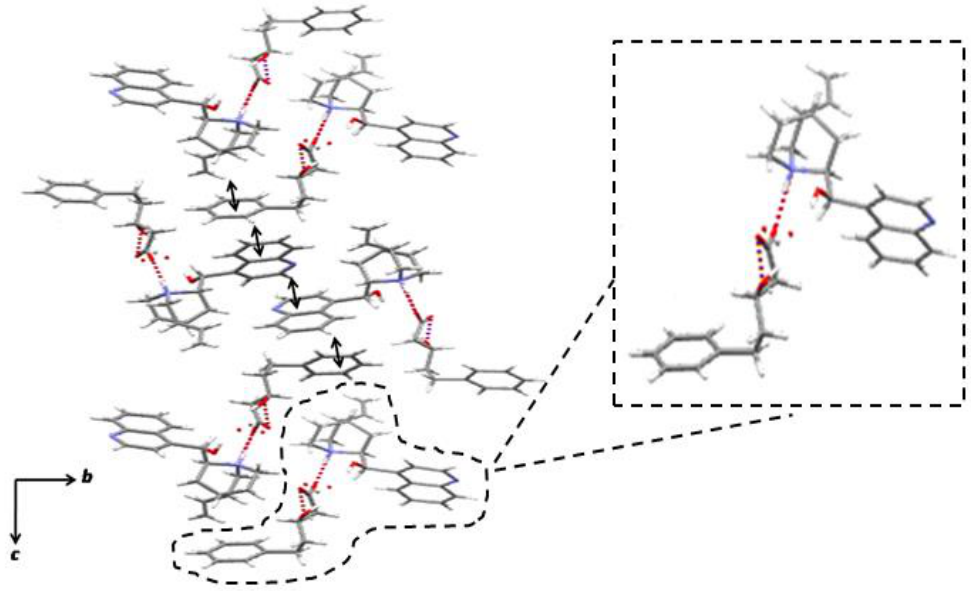
Figure 4. The ( R )- 3 · cinchonidine salt obtained in an AcOEt solution, viewed from the a -axis. The dotted lines and arrows indicate hydrogen bonds and CH/ π interactions, respectively.